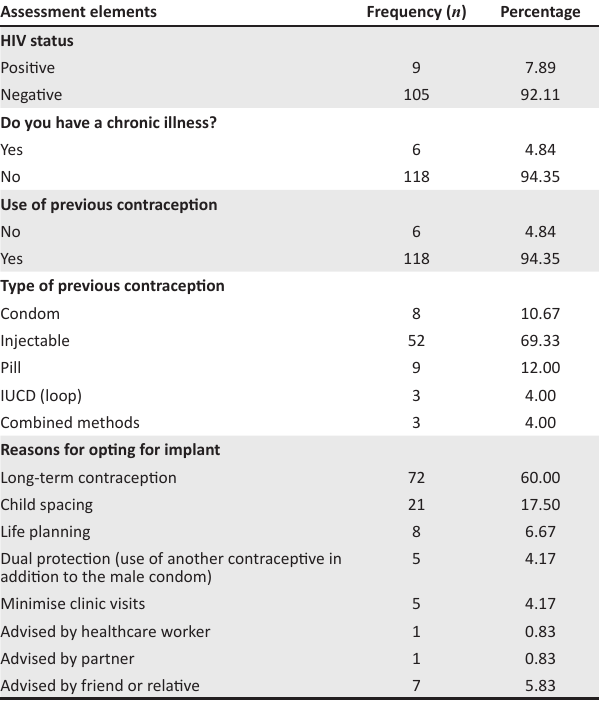
TABLE 3: Assessment of 3-month follow-up post-insertion of the implant. Attendance of 3-month check-up